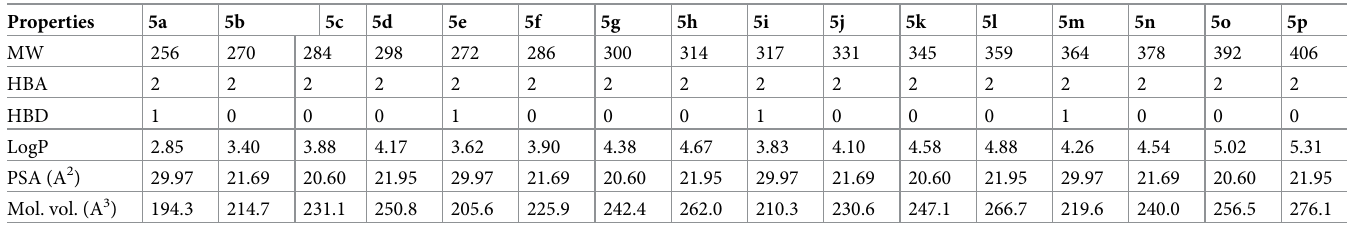
Table 1. Chemo-informatics properties of fuberidazole derivatives.